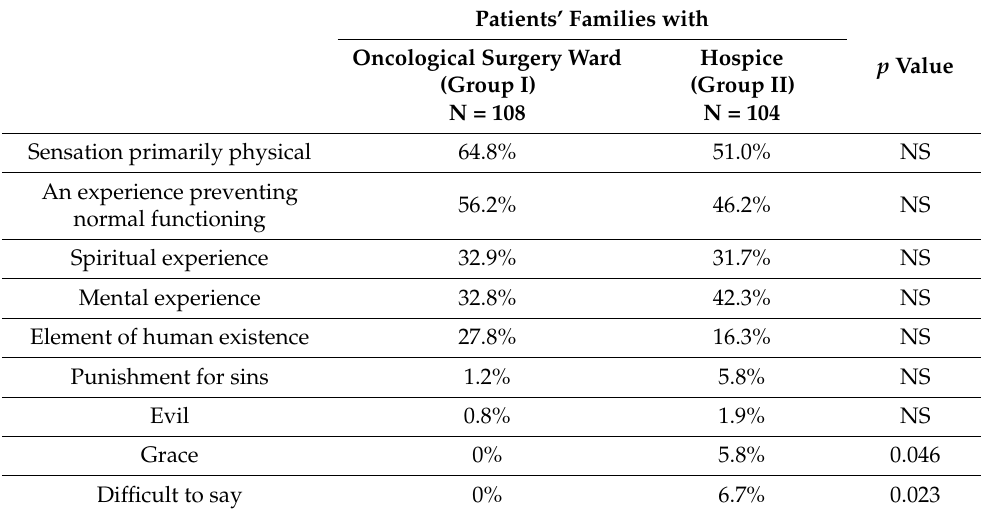
Table 1. Respondents’ opinions about pain and suffering at the end of life *. Patients’ Families with